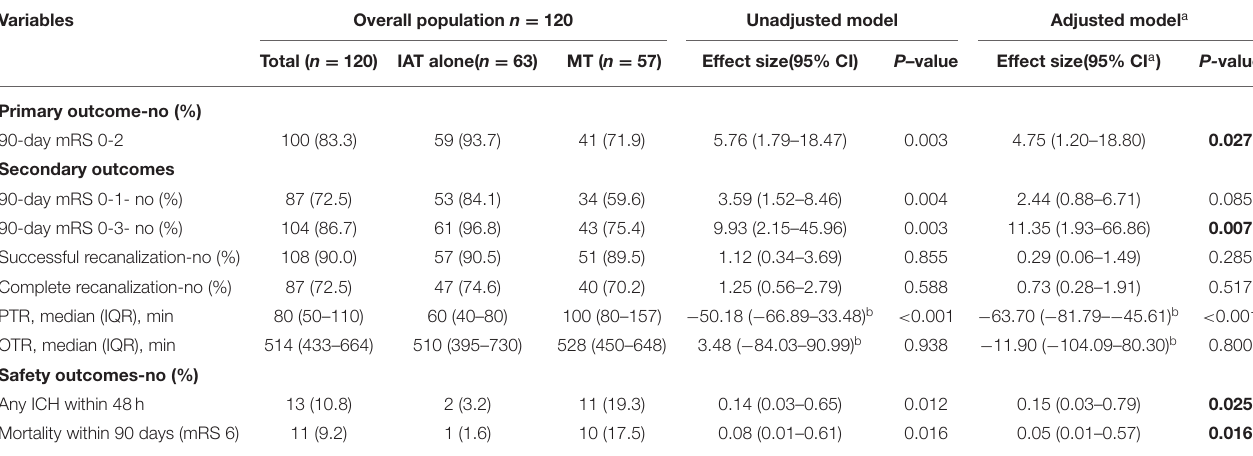
TABLE 2 | Comparison of outcomes between IAT alone and MT groups.